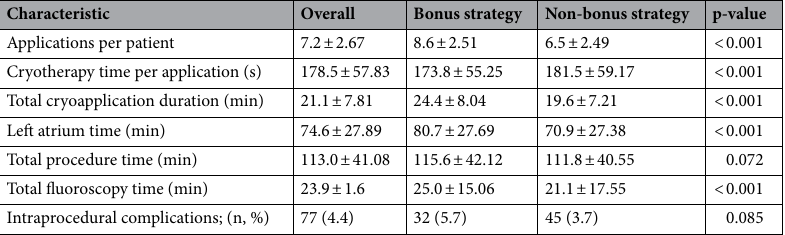
Characteristic Overall Bonus strategy Non-bonus strategy